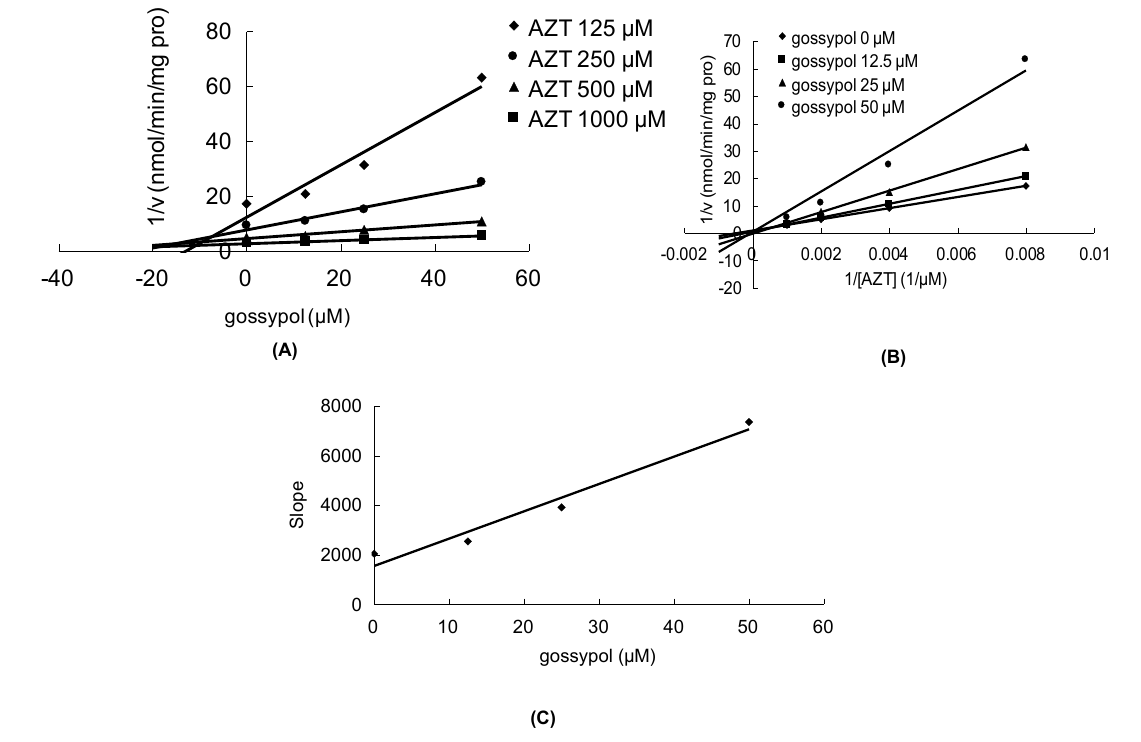
Figure 4. The inhibition of gossypol towards UGT-mediated AZT glucuronidation. ( A ) Dixon plot of the inhibitory effect of gossypol on UGT-mediated AZT glucuronidation; ( B ) Lineweaver-Burk plot of the inhibitory effect of gossypol on UGT-mediated AZT glucuronidation; ( C ) Second plot of slopes from Lineweaver-Burk plot vs . gossypol concentrations. All the experiments were carried out in